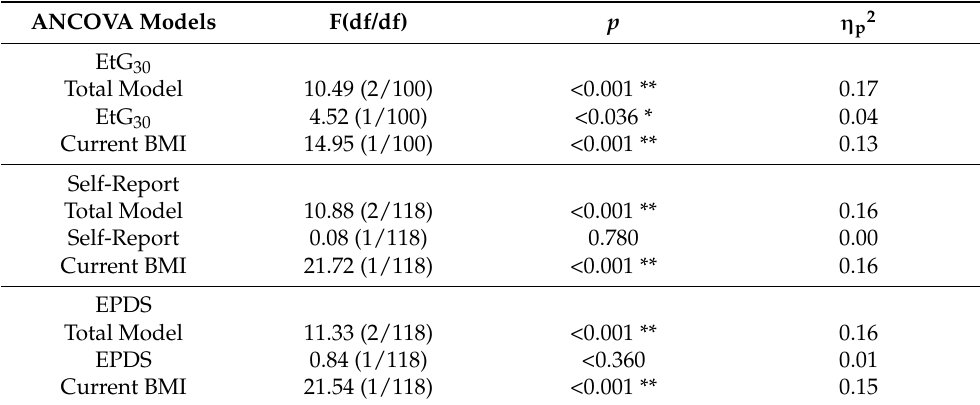
Table 4. Analyses of Covariance for adolescent’s high-sensitive CRP Levels in the EtG and EPDS